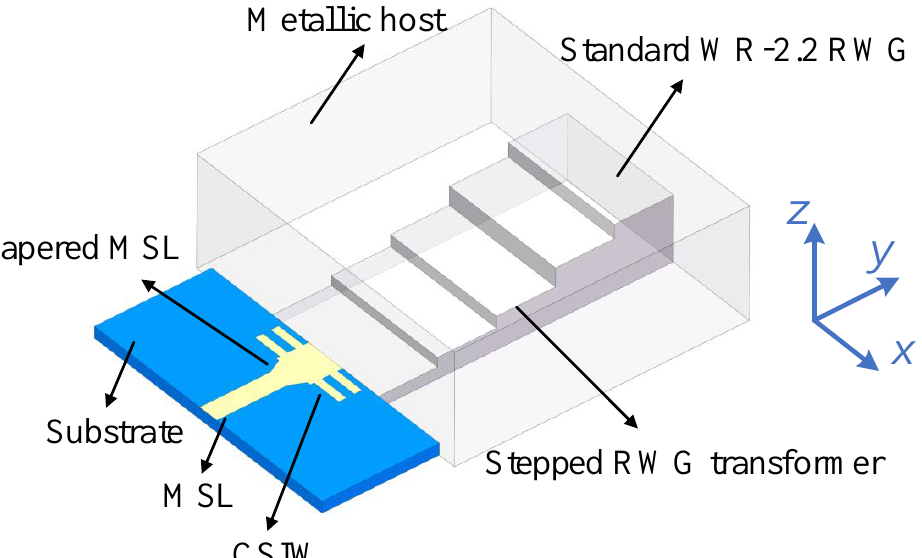
Figure 1. Three-dimensional view of the proposed MSL-to-RWG transition.